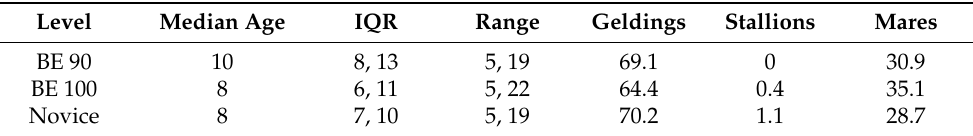
Table 3. Age (median, interquartile range [IQR] and range) and sex distribution, expressed as a percentage, of 841 horses competing in 1010 starts at British Eventing (BE) 90 ( n = 204), 100 ( n = 450) and Novice ( n = 356)